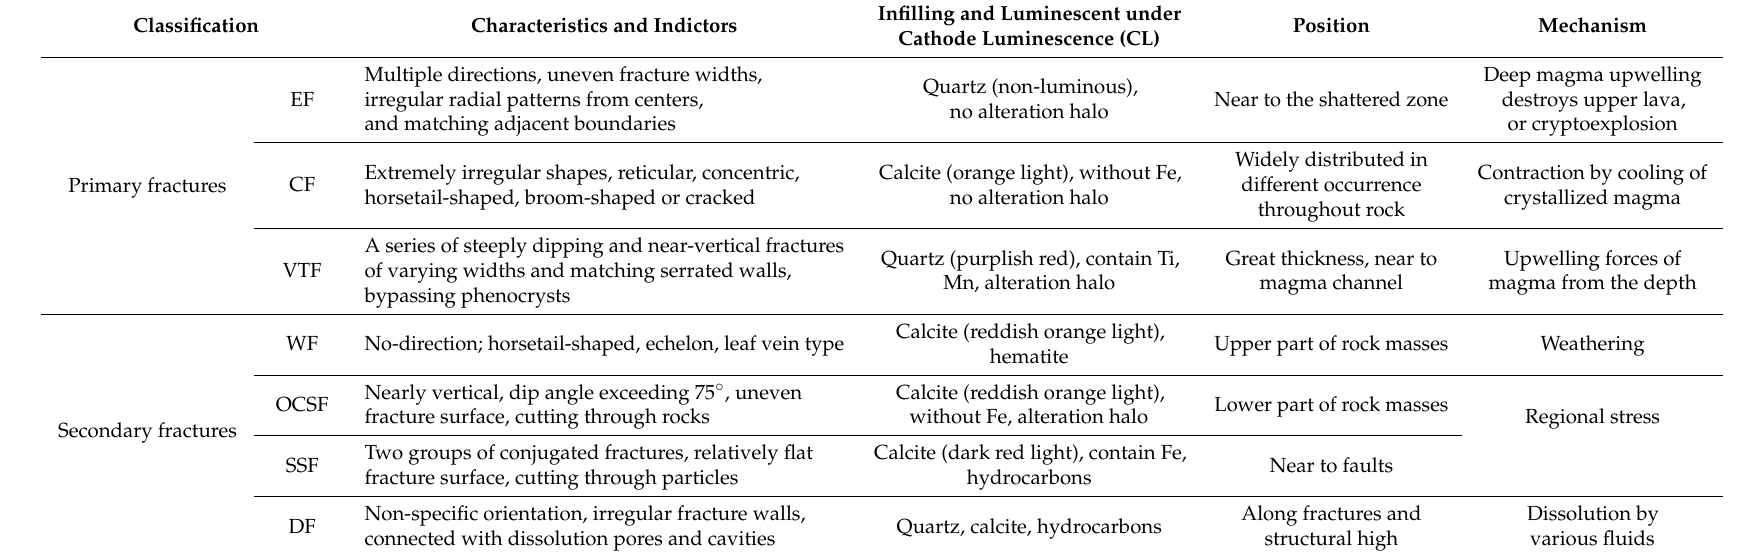
Table 1. Classification and filling characteristics of volcanic fractures in the Dixi